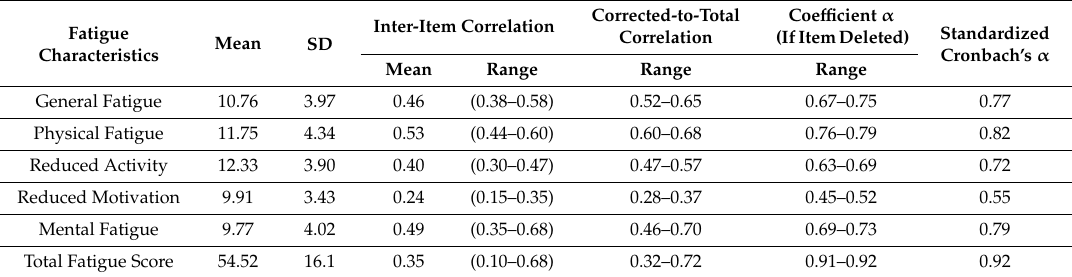
Table 2. MFI-20 scale item characteristics and internal consistency reliabilities.